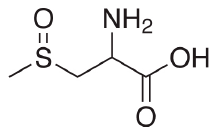
Figure 7. Structure of S-methyl cysteine sulfoxide.